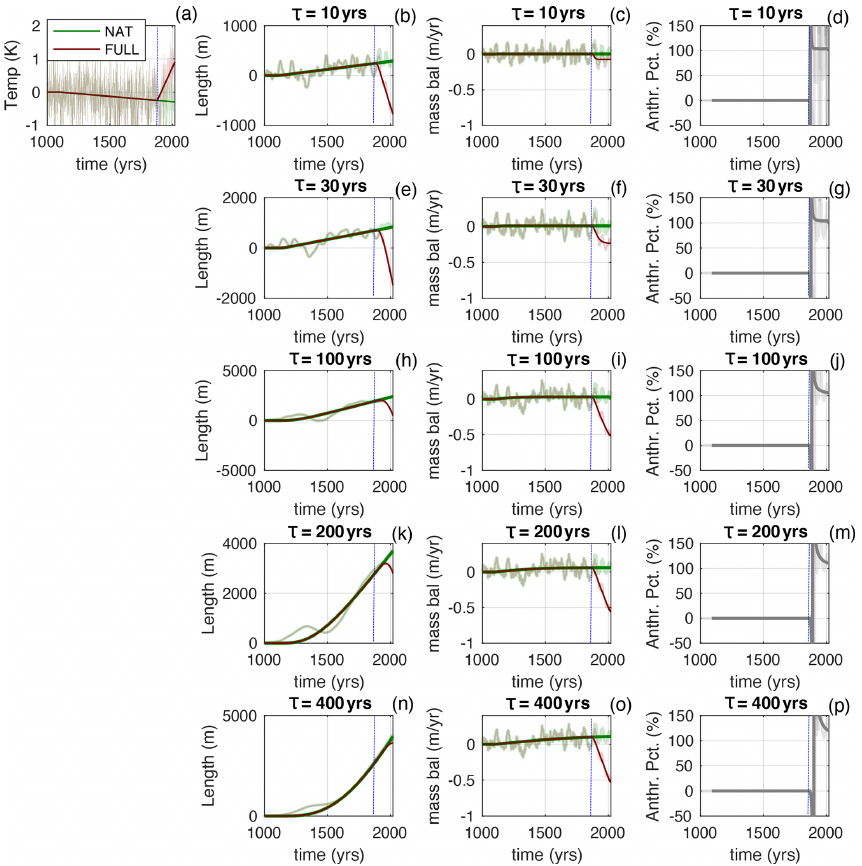
Figure 2. Synthetic simulations of the last millennium. (a) Temperature history, with NAT case (green line) and FULL case (red line). The lighter thinner lines have white noise added. The columns on the right show, in each row, the length, the mass balance, and the magnitude of the anthropogenic mass loss relative to the total (i.e. F anth ) for glaciers with timescales of 10, 30, 100, 200, and 400 years, respectively. The mass balance and F anth have a 20-year running mean applied, as in Marzeion et al.